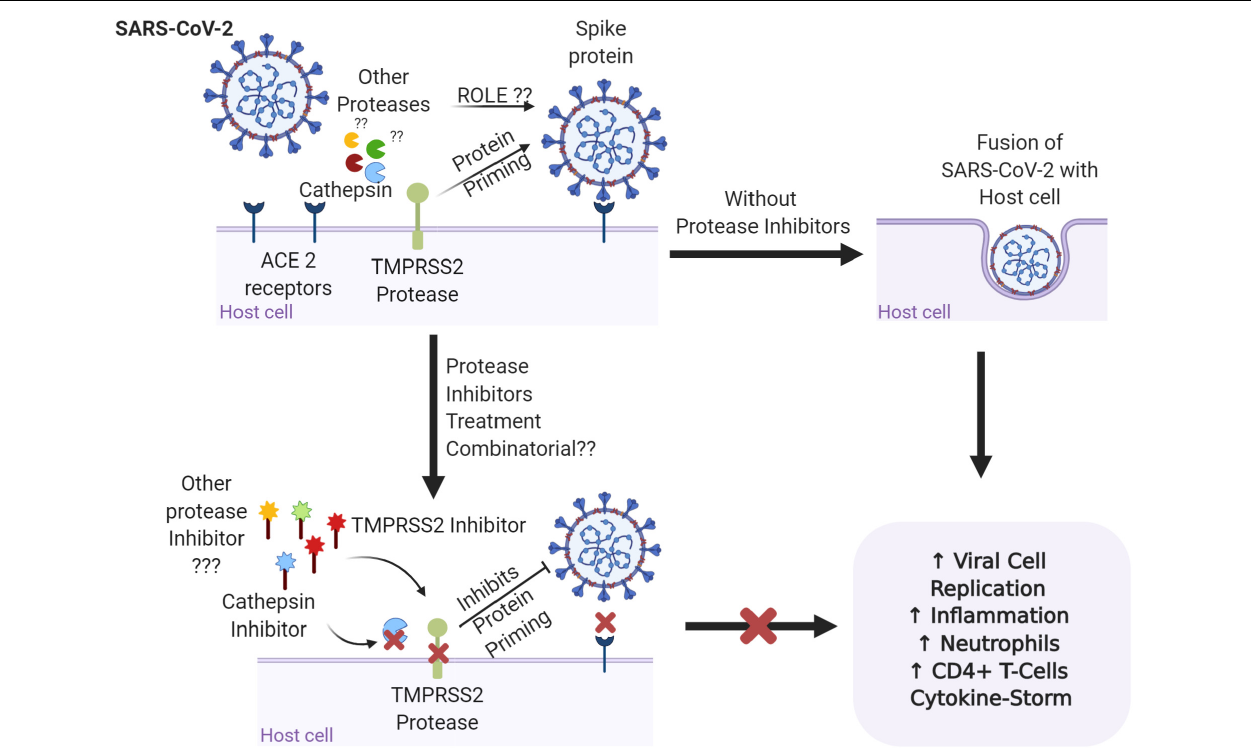
FIGURE 1 | Representation of the binding of the spike protein on the surface of SARS-CoV-2 to the ACE2 receptors on the surface of the host cell. TMPRSS2 and cathepsin are involved in priming of the S glycoprotein and promoting viral invasion, leading to imbalance in the immune response and disease severity. Are other proteases involved in the proteolytic cascade of viral invasion? Targeting the proteases with specific protease inhibitors either alone or in combination may have better therapeutic potential for SARS-COV-2 infections. Figure prepared on biorender.com, professional science figure creating